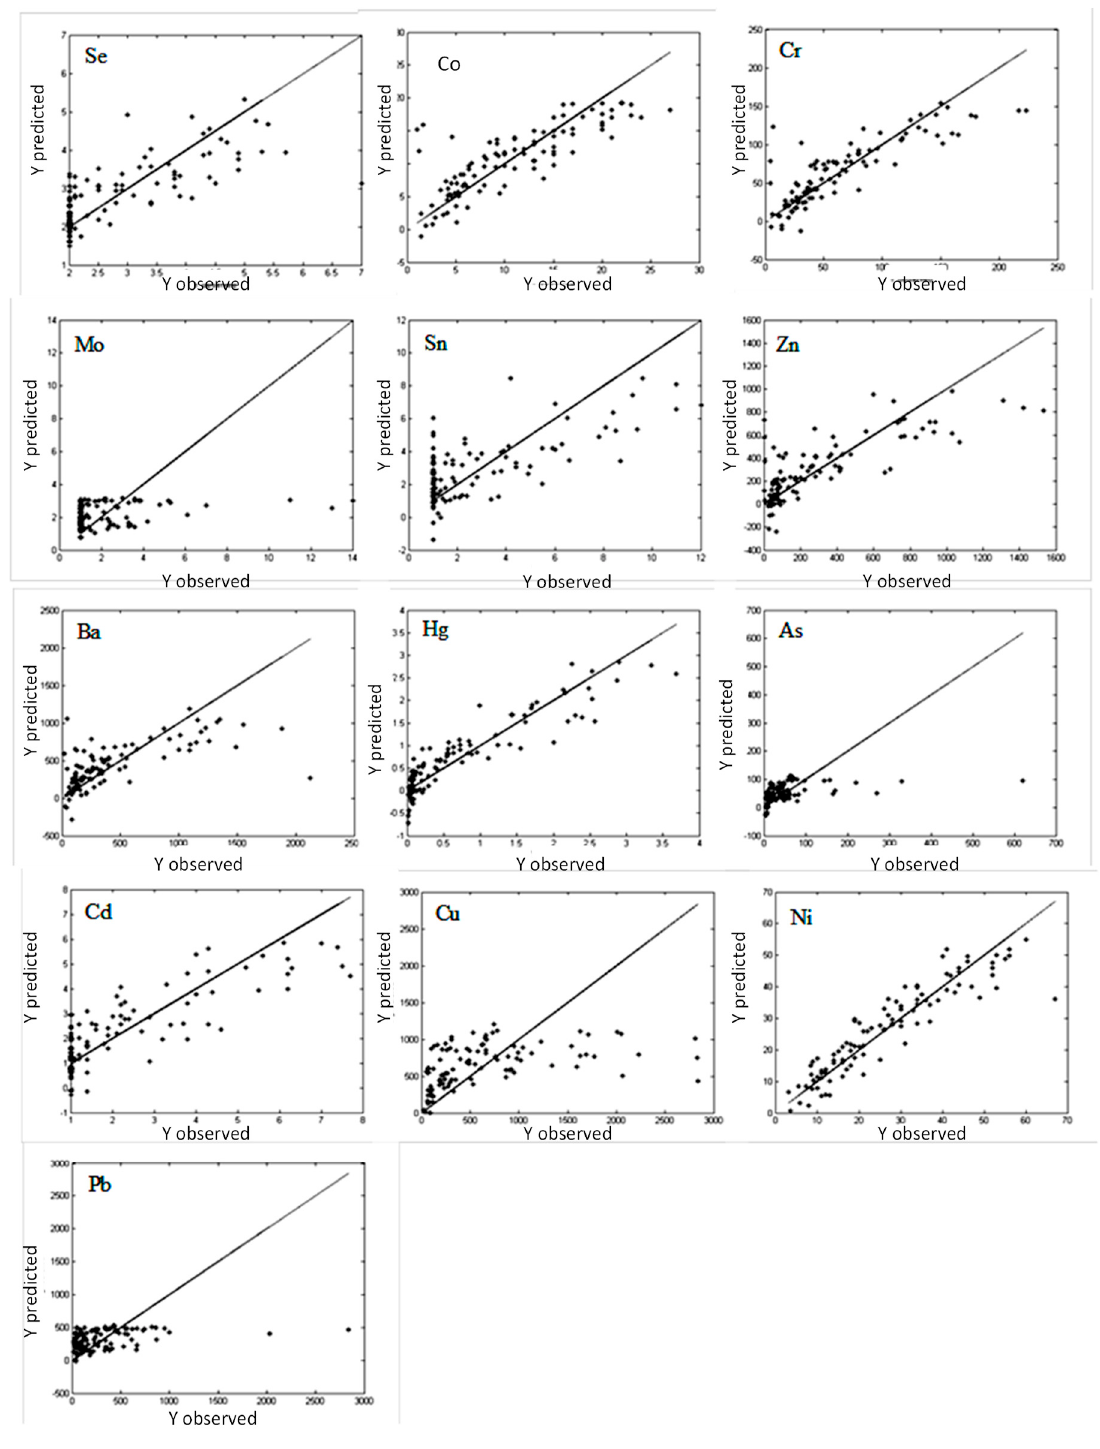
Figure 6. The PLS model describing the relationship between the metal content in soil and spectral data measured using the DRIFT in the MIR.